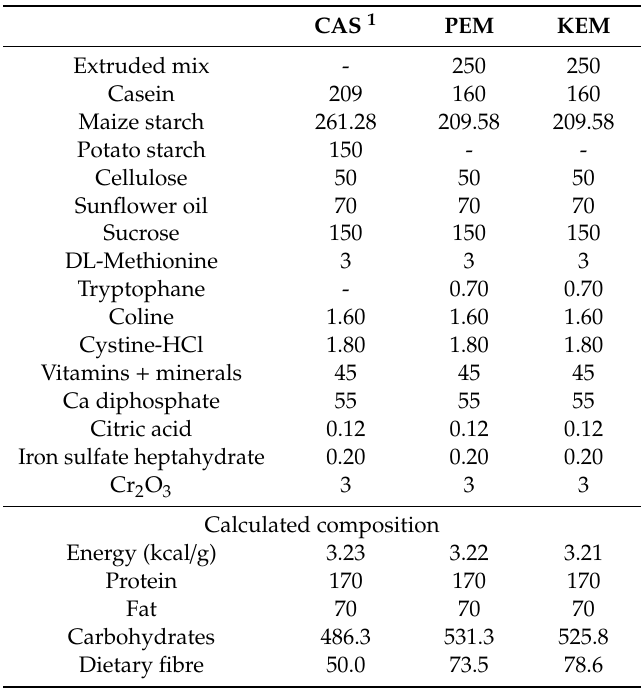
Table 2. Composition (g / kg) of the